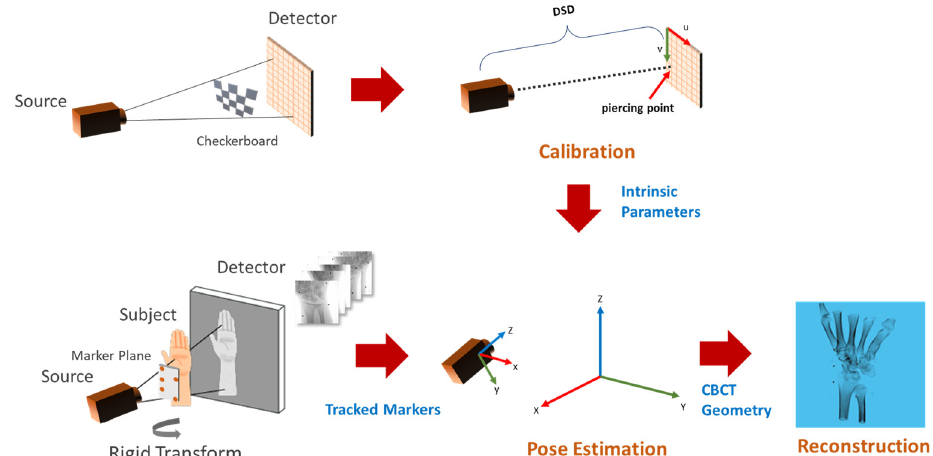
Figure 1. Overview of the calibration and reconstruction pipeline. The C-arm is calibrated using multiple captures ( top left ) of the calibration checkerboard to obtain intrinsic parameters ( top-center ). A planar marker board is attached to the subject before X-ray acquisition ( bottom left ). Markers in the acquired multi-view images are tracked for pose estimation ( bottom center ), followed by the reconstruction algorithm ( bottom right ).